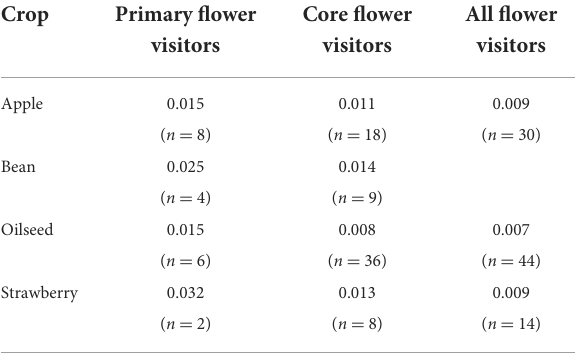
TABLE 2 Standard deviation of mean occupancy for primary, core and all flower visitors per crop (number of species in